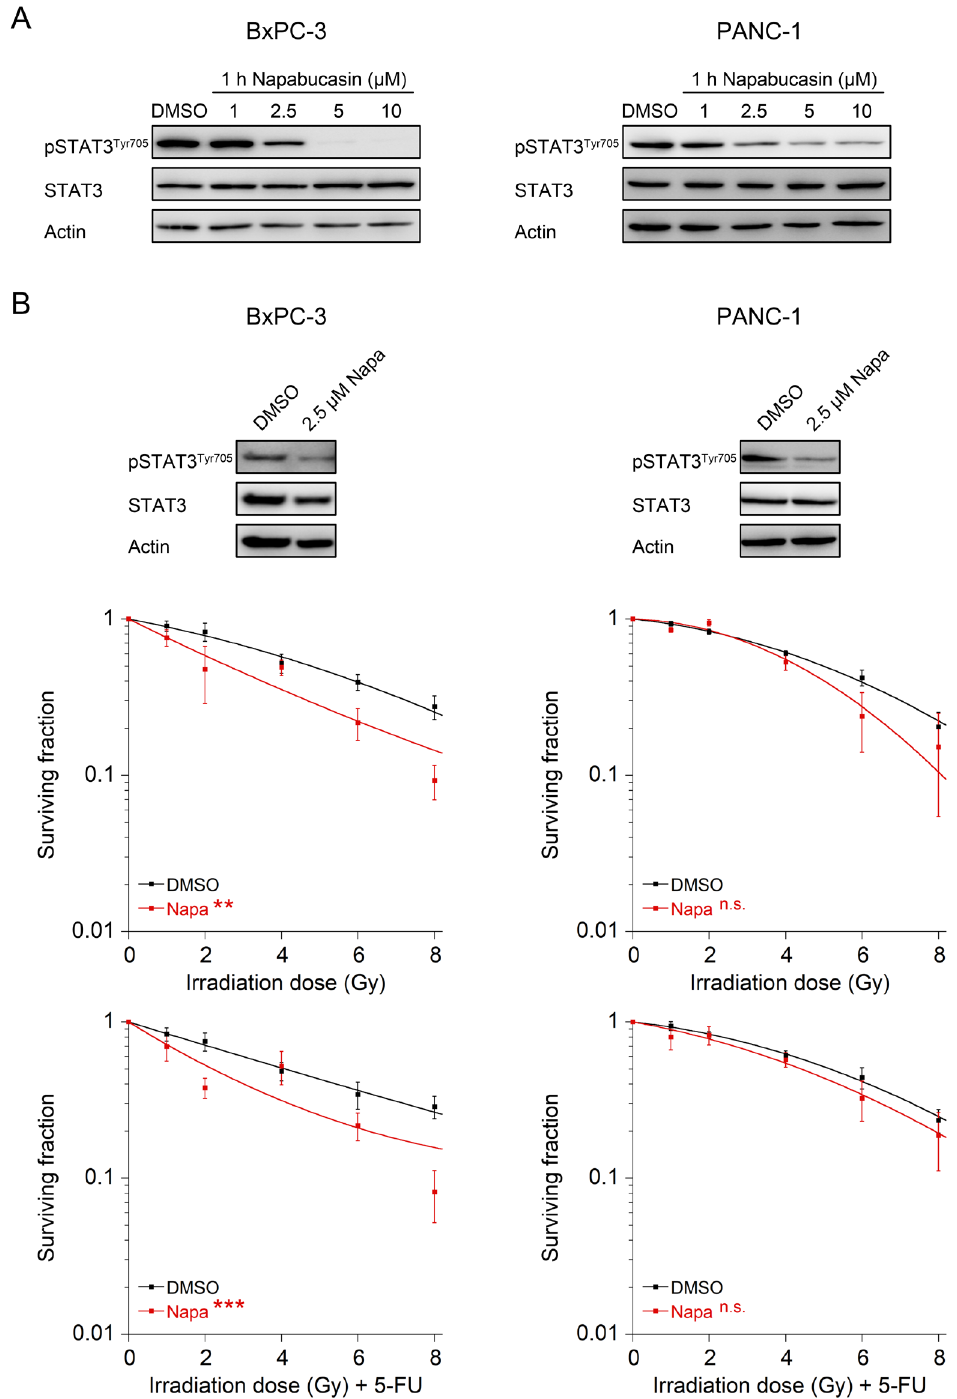
Figure 4. Pharmacological inhibition of STAT3 signaling with napabucasin induces re-sensitization to irradiation and chemoradiotherapy. ( A ) Establishment of effective napabucasin (Napa) concentrations in BxPC-3 (left panel) and PANC-1 cells (right panel); ( B ) BxPC-3 cells (left panels) and PANC-1 cells (right panels) were left untreated (DMSO) or treated with the STAT3 inhibitor napabucasin for 1 h. Depletion of pSTAT3 Tyr705 was monitored by Western blot analysis after stimulation with 100 ng/mL IL-6 (upper panel), and cells were subjected to CFA survival after RT (upper graphs) or CRT (lower graphs). Data are presented as mean ± s.e.m. from at least 3 independent biological replicates. ** p < 0.01, *** p < 0.001, two-way analysis of variance (ANOVA). For p -values, see Table S1.